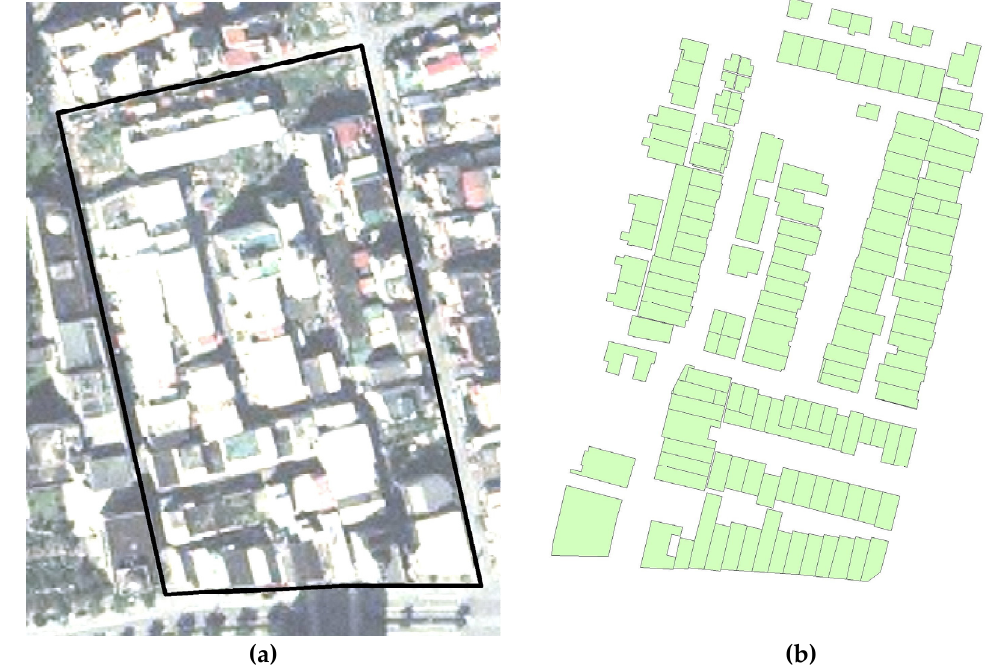
Figure 3. Population estimation by means of rooftop counting. ( a ) Orthophoto or satellite image; ( b ) Rooftop digitizing